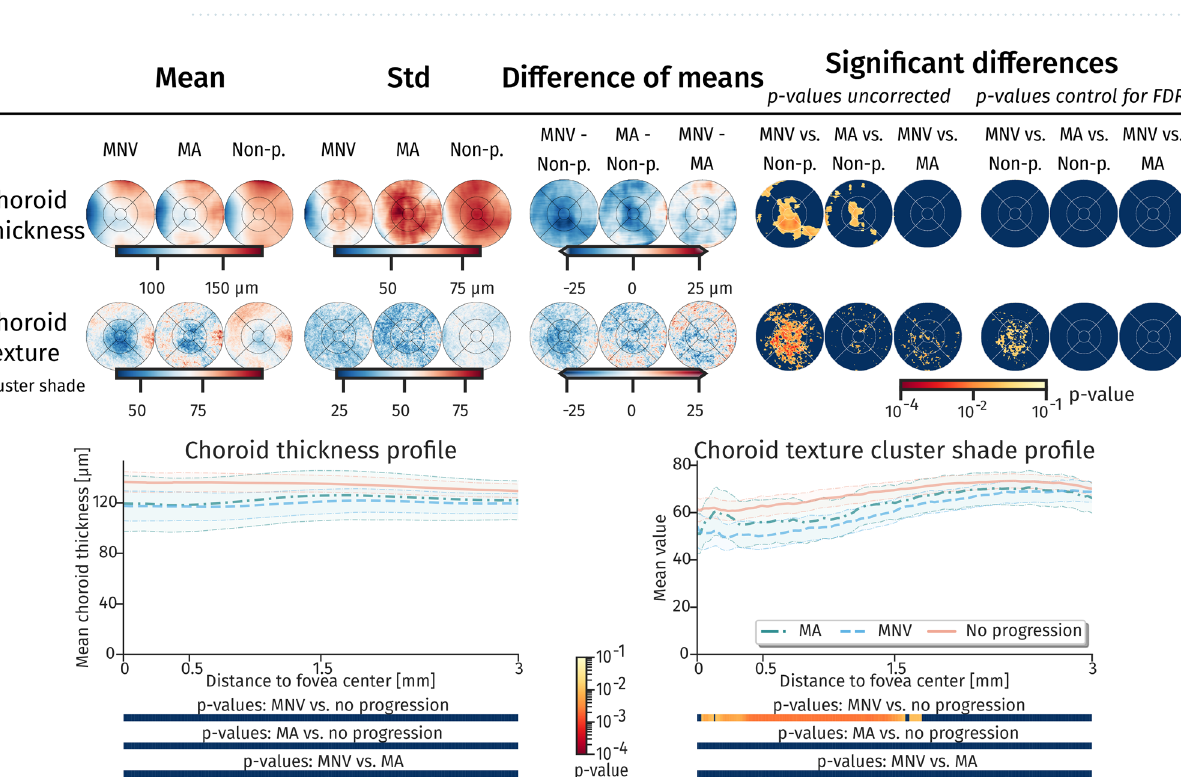
Figure 5. Topographic profile of layers outer nuclear layer (ONL) and outer retinal hyperreflective bands (ORB). The area around mean curves show the 0.95 confidence interval of means. The bars below the profiles illustrate the significance level in terms of p-values from a Mann-Whitney U test at the given distance to fovea. P-values are corrected for 5% false discovery rate.